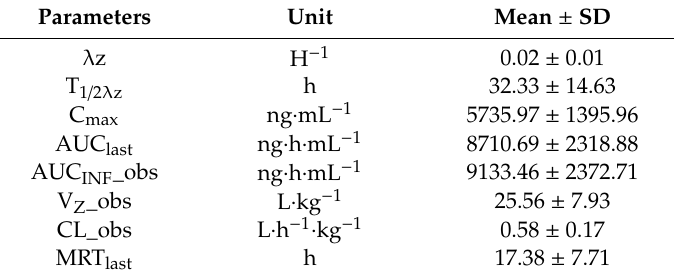
Table 5. Pharmacokinetic parameters of lekethromycin after intravenous administration (5 mg / kg) in